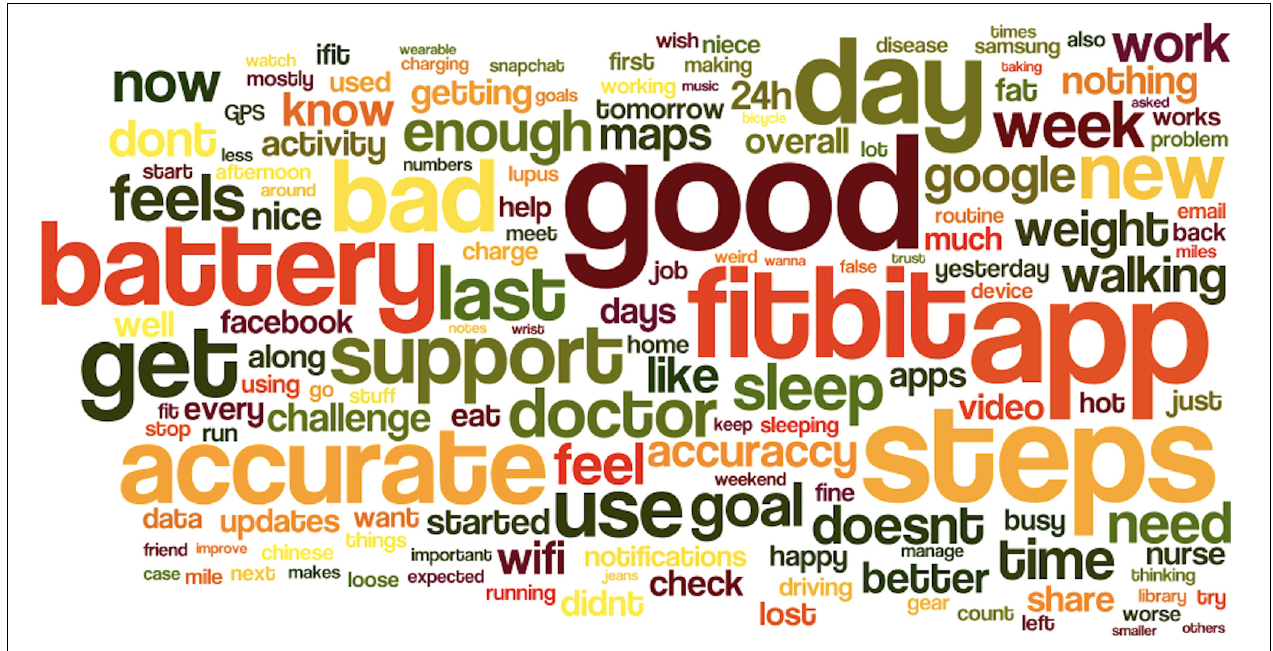
FIGURE 3 | Expressions in user’s interviews and